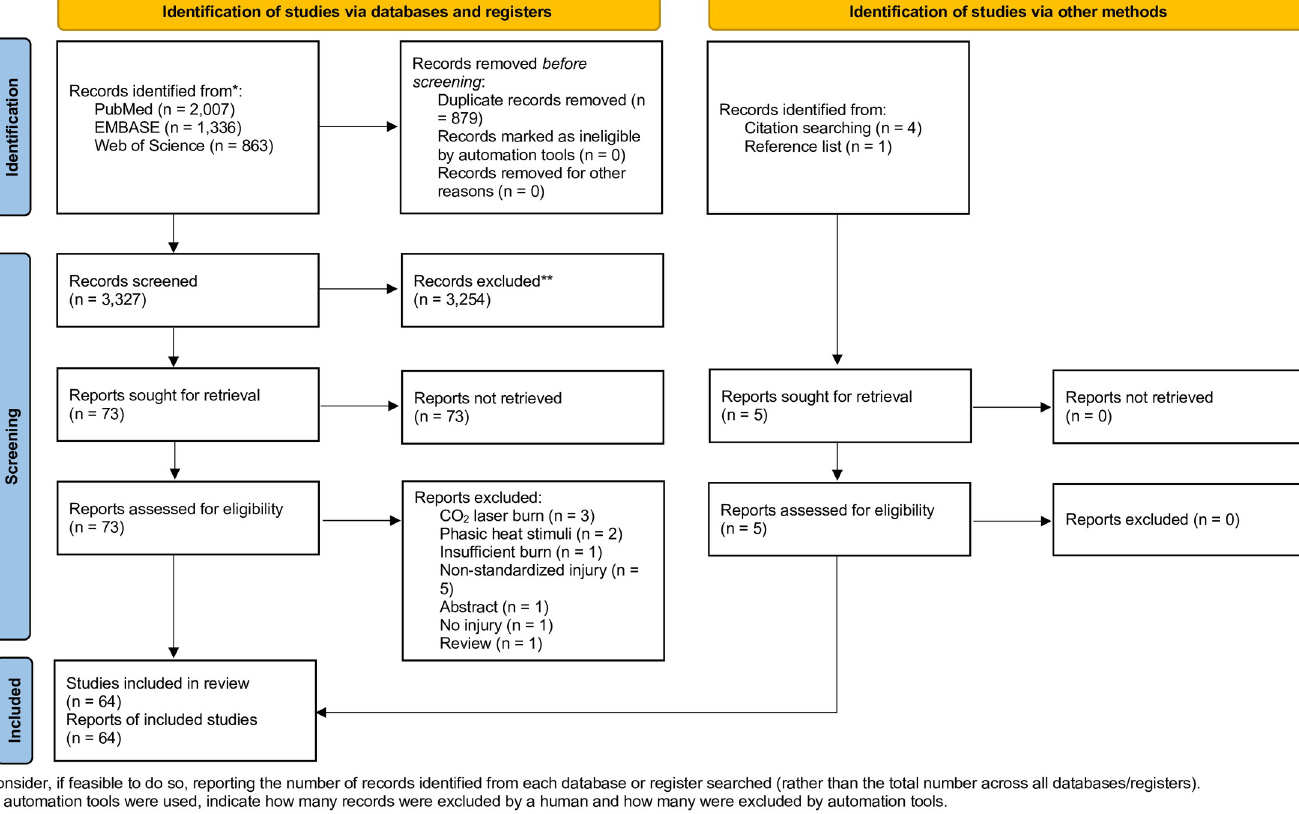
Fig 1. PRISMA flow diagram for the search algorithm